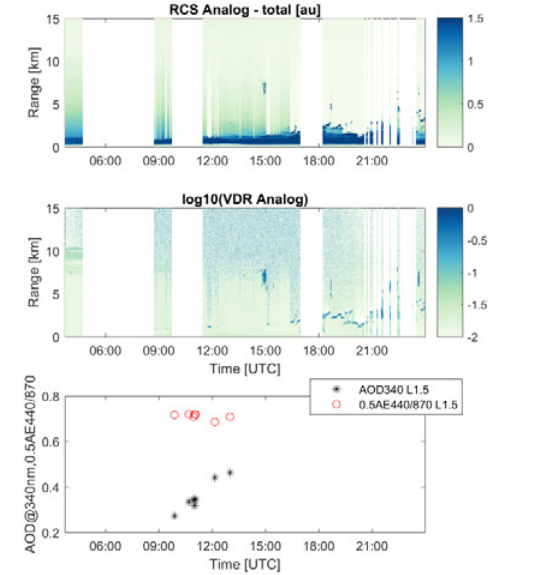
Figure 2. RCS (upper), VDR (middle) and AOD and AE (lower) at Camborne on 24/05/2016 during a biomass burning event.